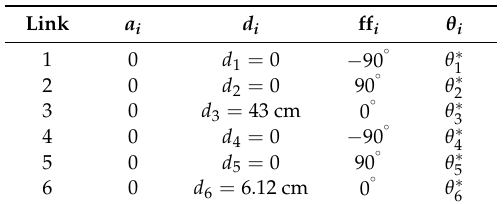
Figure 3. The 3-D geometry of a two-joint robot model with each joint having 3-DOF. Note that the origins of coordinate Frames 0, 1 and 2 coincide collectively, forming Physical Joint I, which has 3-DOF. The origins of Frame 3, 4 and 5 coincide to form Physical Joint II having 3-DOF. Table 1. Denavit-Hartenberg (D-H) parameters of 3-D model shown in Figure 3. The parameter with an asterisk (*) mark denotes that it is